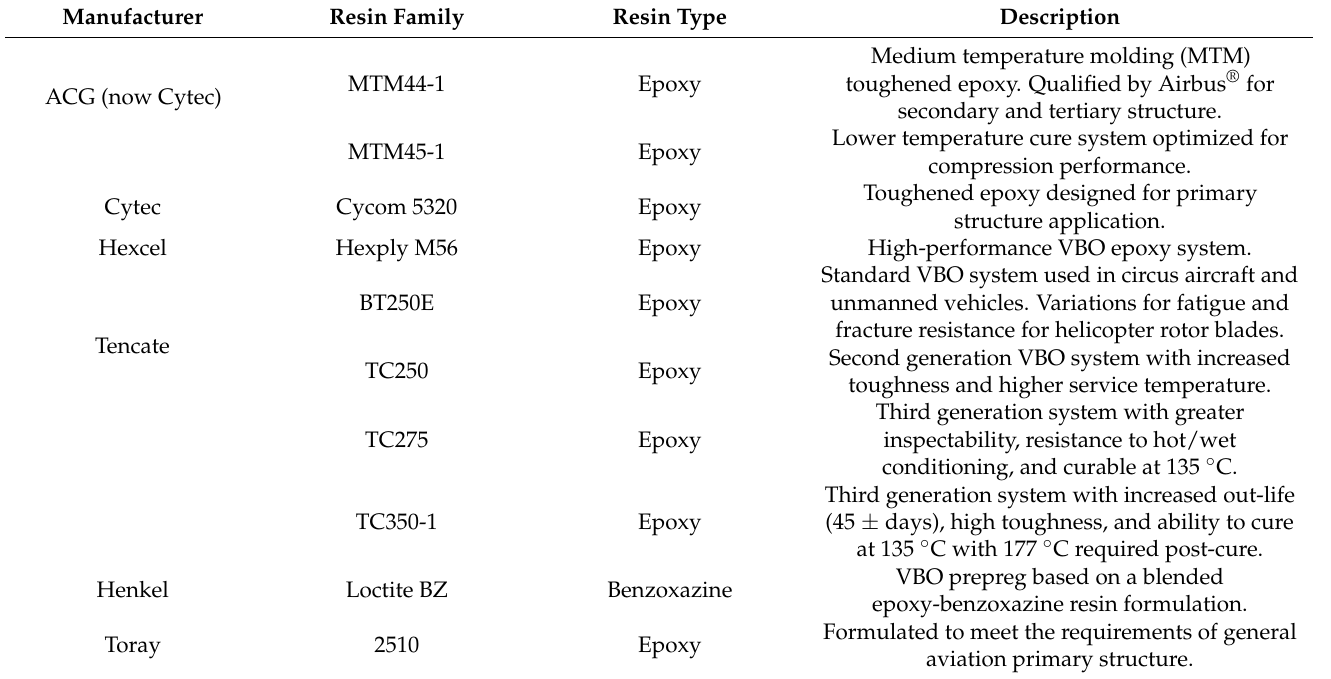
Table 2. Current-Generation Aerospace-Grade OoA/VBO Prepreg Resin Systems [21]. Reprinted with permission from